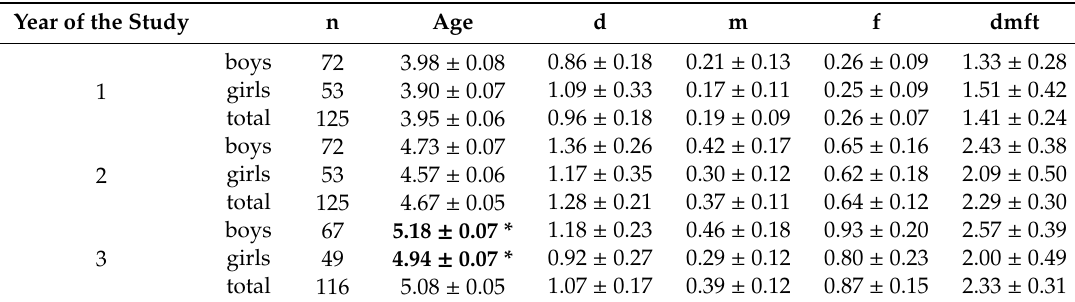
Table 1. The average age and gender of all children and their dmft index (d—number of teeth with untreated dental caries, m—number of teeth extracted due to dental caries, f—number of teeth with caries treated with a filling or crown,